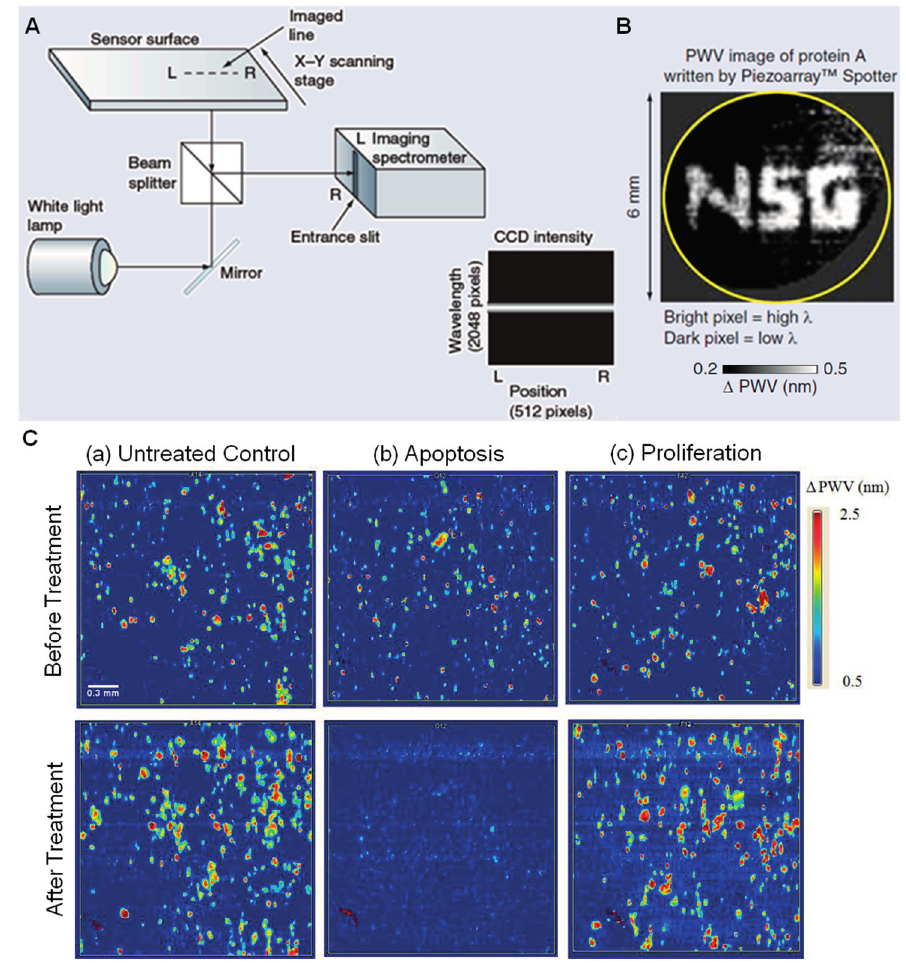
Figure 2. Instrument 1: Label-free Biomolecular Interaction Detection (BIND) Scanner utilizing a PC surface biosensor. ( A ) Schematic of excitation/detection instrument where an imaging spectrometer gathers hundreds of reflected spectra simultaneously from one line across the sensor surface; ( B ) PWS images of Protein A (bright regions represent regions of greater PWS) gathered on a 6-mm diameter region of a PC biosensor, which is imaged at approximately 20 µm pixel resolution after writing the letters ‘NSG’ (Nano Sensors Group) with a microarray spotting tool (PerkinElmer, Inc. Piezoarray™) (Reprinted in part with permission from [50], © 2006 Future Drugs Ltd.); ( C ) PWS images with shift scale bars ( Δ PWV) indicating the magnitude of wavelength shifts in nanometers. Pixels with higher PWS displayed in brighter colors indicate locations where Panc-1 cell attachment has occurred. The three columns of image sets represent the following: (a) untreated control, (b) extract that induced 100% cell death Petunia punctata Paxton ( P. punctate ), (c) extract that enhanced proliferation Anisoptera glabra Kurz ( A. glabra ). The top row of images was taken before exposure and the bottom row of images was taken after the 24 h exposure period with a plant extract at 100 μ g/mL. Scale bar (white) = 300 μ m (Reprinted in part with permission from [41], © 2010 BioMed Central